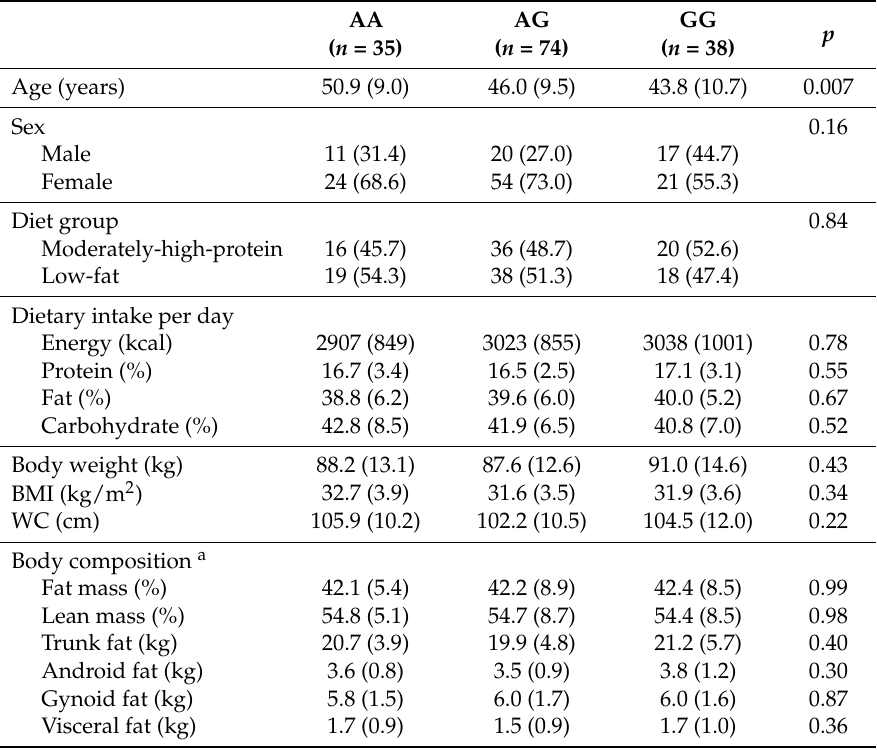
Table 2. Baseline characteristics concerning dietary and body composition measurements of the participants, depending on the ADCY3 rs10182181 genetic variant.